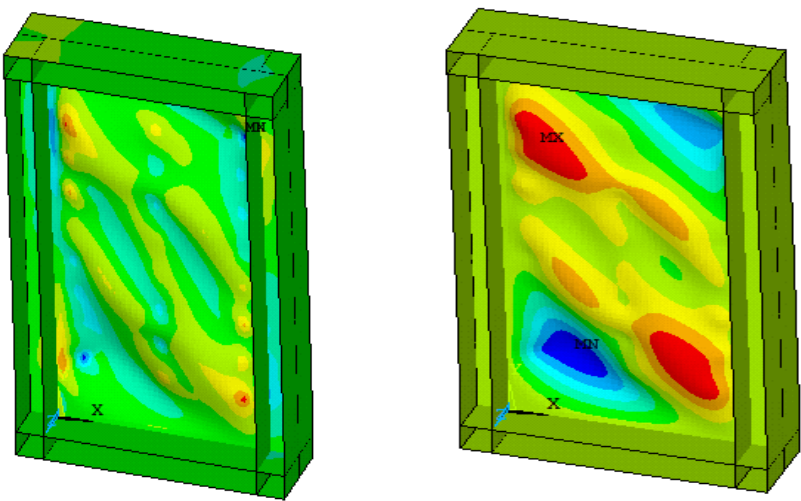
Figure 6. Local buckling, out-of-plane deflection for numerical specimen.